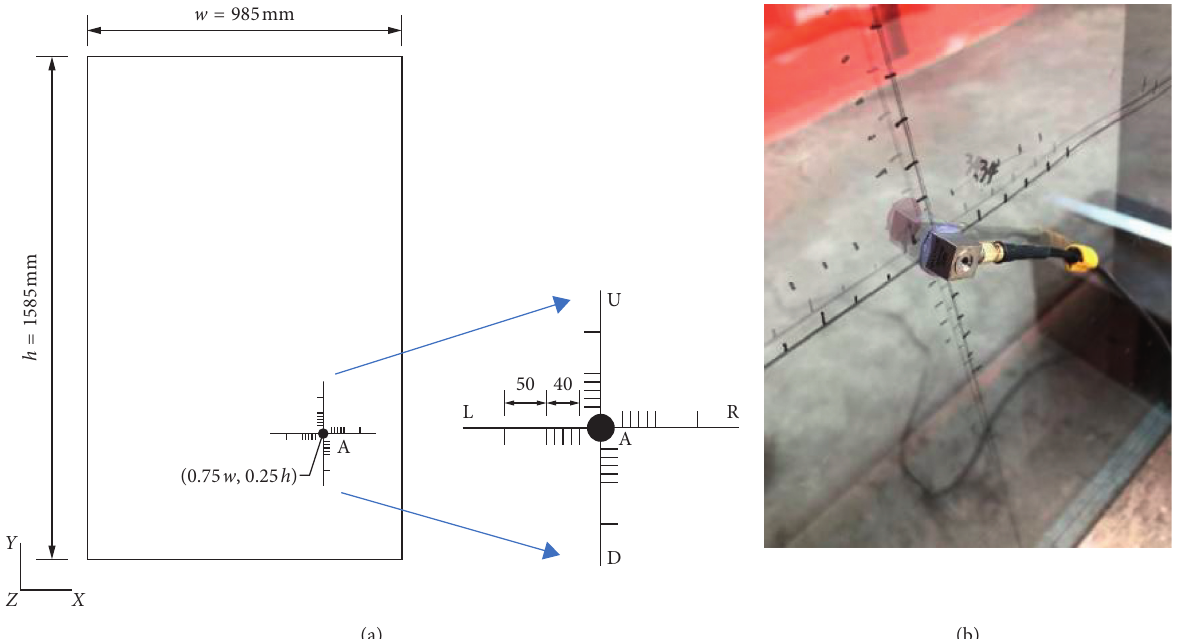
Figure 7: Hammer impact locations: (a) tapping locations (unit: mm) and details of point A (unit: mm); (b) photo of the experimental setup.